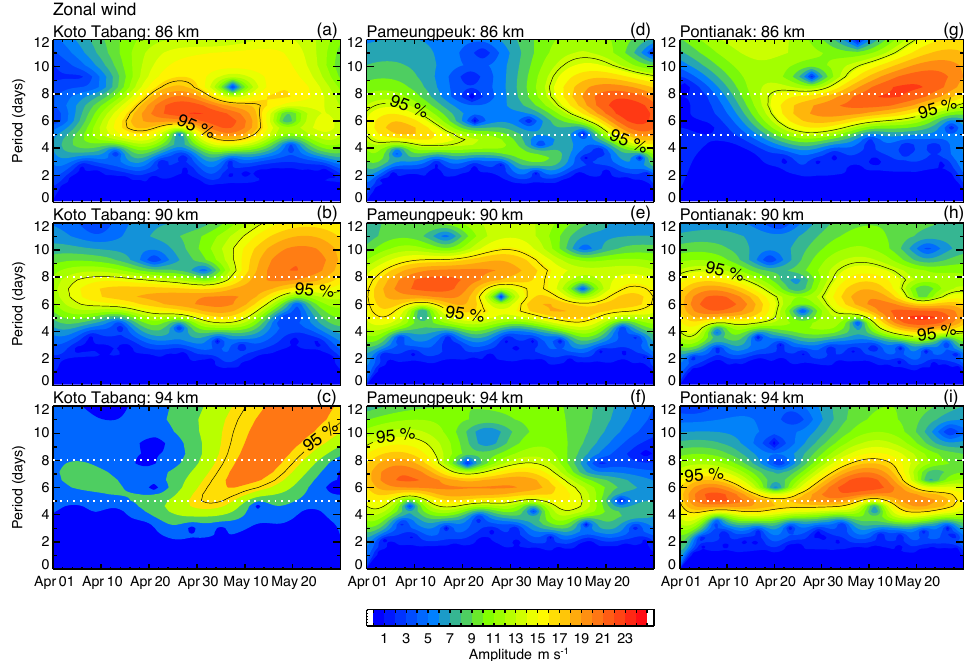
Figure 10. Contours of wavelet intensities as a function of frequency and time for the zonal wind of IMF5 at three different heights (86, 90, and 94km) over Kototabang, Pameungpeuk, and Pontianak